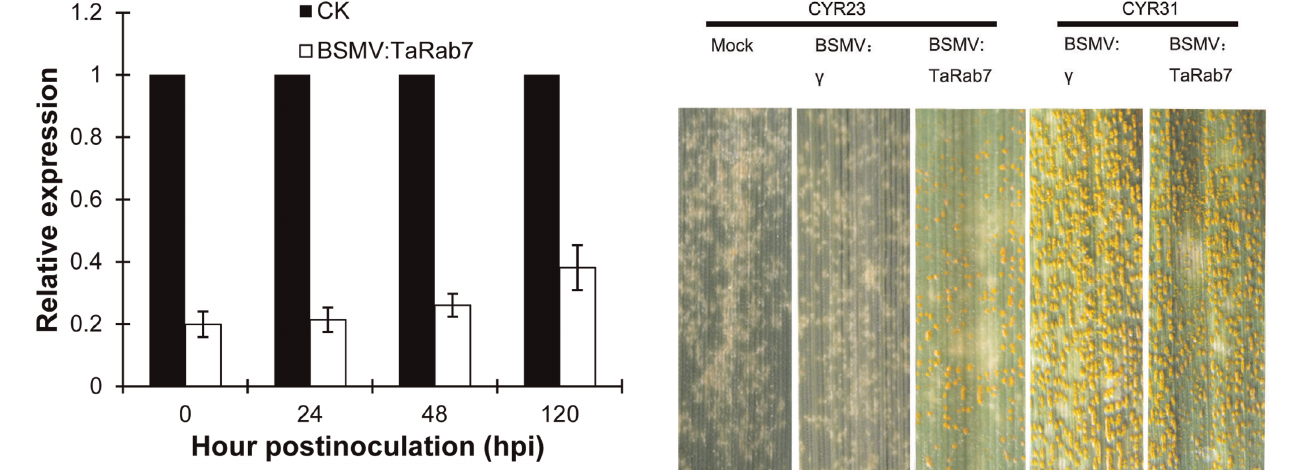
Figure 7. Relative transcript levels of TaRab7 assayed by qRT- PCR after TaRab7 gene silencing by the BSMV-VIGS method. RNA samples were isolated from the fourth leaves of the wheat seedlings infected with BSMV:TaRab7 at 0, 24, 48 h and 120 post- inoculation (hpi) after inoculation with CYR23. CK: wheat leaves infected with BSMV: c were sampled immediately (0 hpi) after inoculation with CYR23. Error bars represent the variations among three independent replicates.